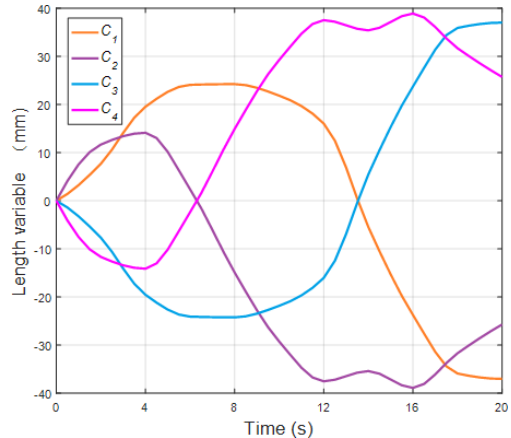
Figure 15. Length changes of cables for the terminal section.